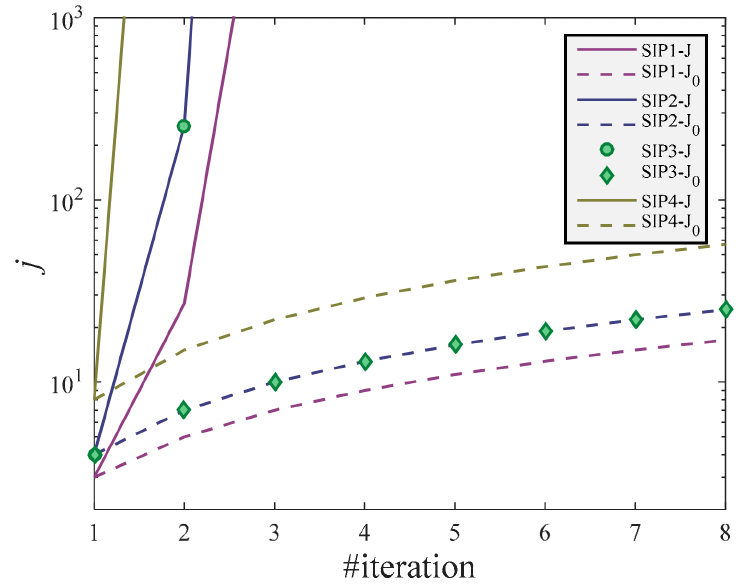
Figure 2. Convergence degree of the error vector e ( 0 ) at different iteration counters. Table 2. Comparison of the convergence rates of studied PF solution techniques.